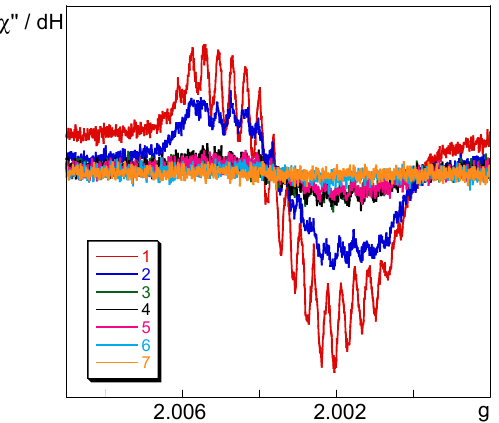
Figure 5. A comparison of the EPR spectra of 1 – 7 with pyrrolidine (2 × 10 − 3 M equimolecular solutions in DMSO/water 4:1 v / v ). The measurements were carried out 11 min after the addition of the amine. Experimental details of the data collection: modulation amplitude 0.02 mT, time constant 40.96 ms, conversion time 327.68 ms, gain 6.32 × 10 4 , power 20 mW, and three scans in all cases. Microwave frequencies were 9.7732 ( 1 ), 9.7726 ( 2 ), 9.7724 ( 3 ), 9.7727 ( 4 ), 9.7716 ( 5 ), 9.7713 ( 6 ), and 9.7715 GHz ( 7 ).